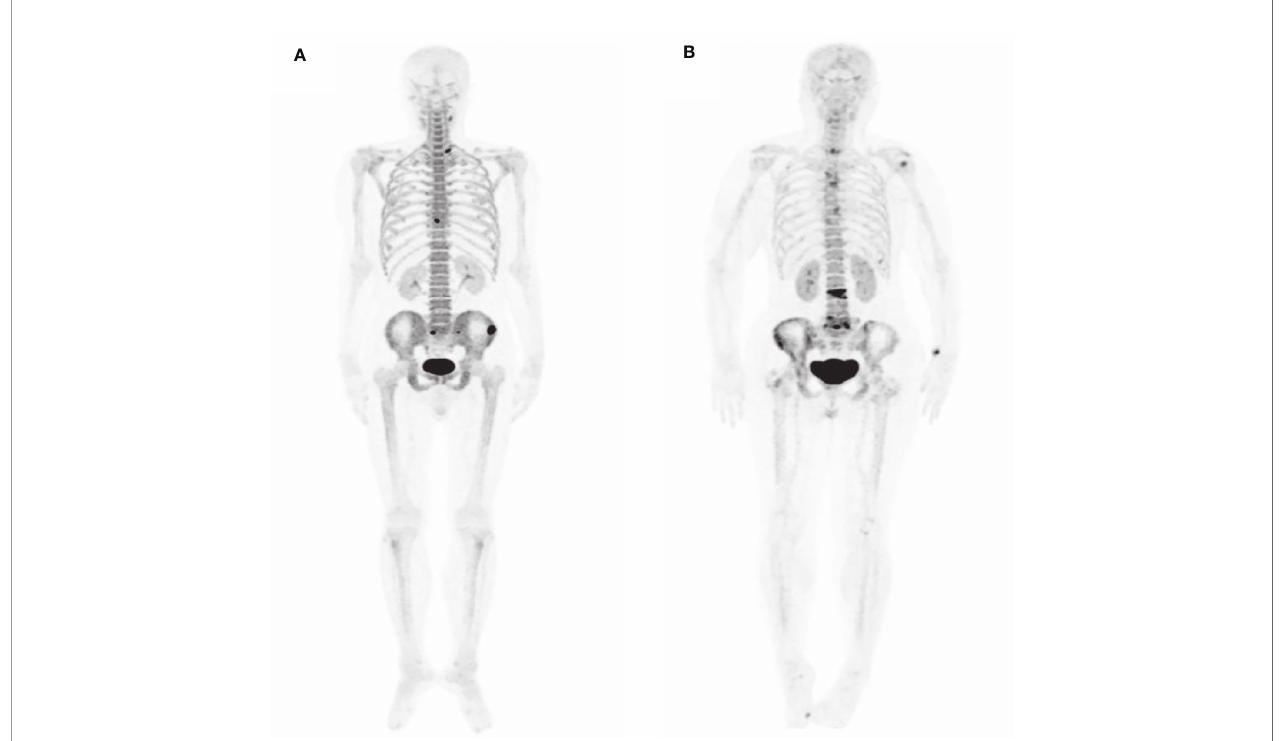
FIGURE 6 | MIP PET images of two patients with multiple bone metastases. (A) A 53 y male patient with Left lung adenocarcinoma. (B) A 50 y female patient with invasive ductal carcinoma of the left